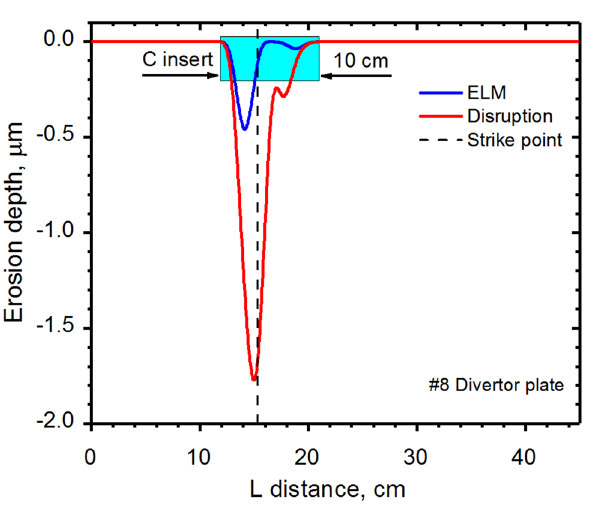
Figure 9. HEIGHTS simulation of divertor plate erosion crater and proposed carbon insert location. The images were prepared using OriginPro